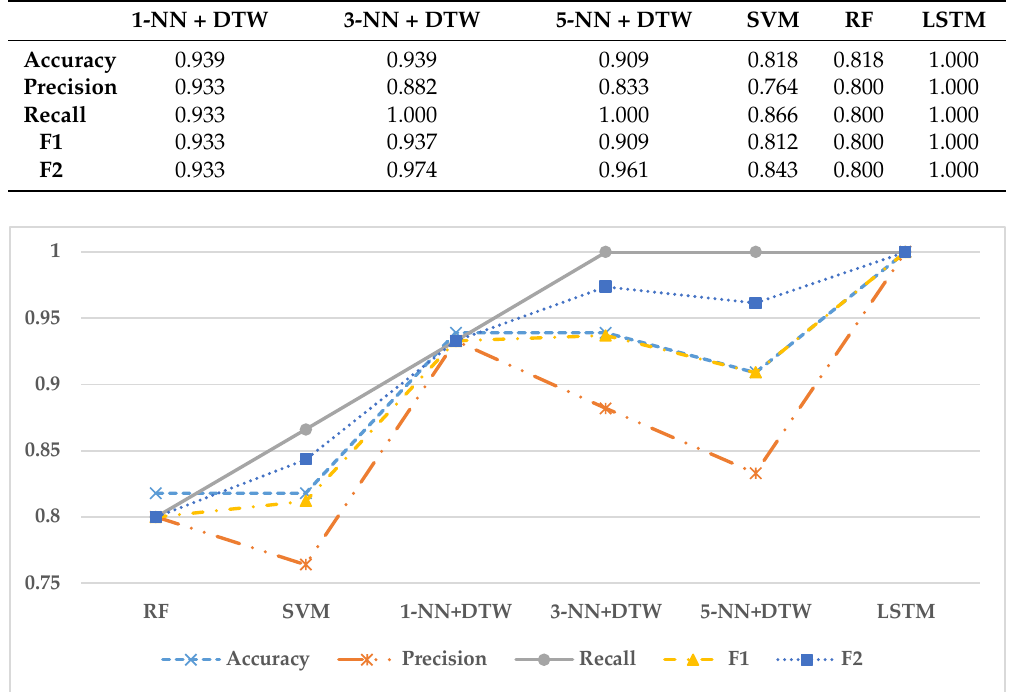
Figure 6. Performance comparison of six models. LSTM shows the best performance in terms of F1 and F2 scores.